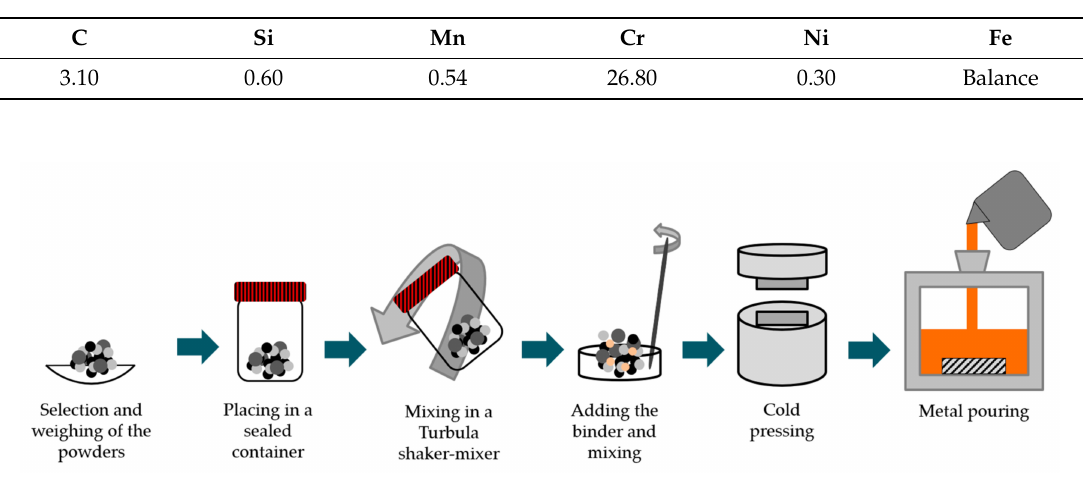
Figure 1. Scheme of the fabrication steps performed.